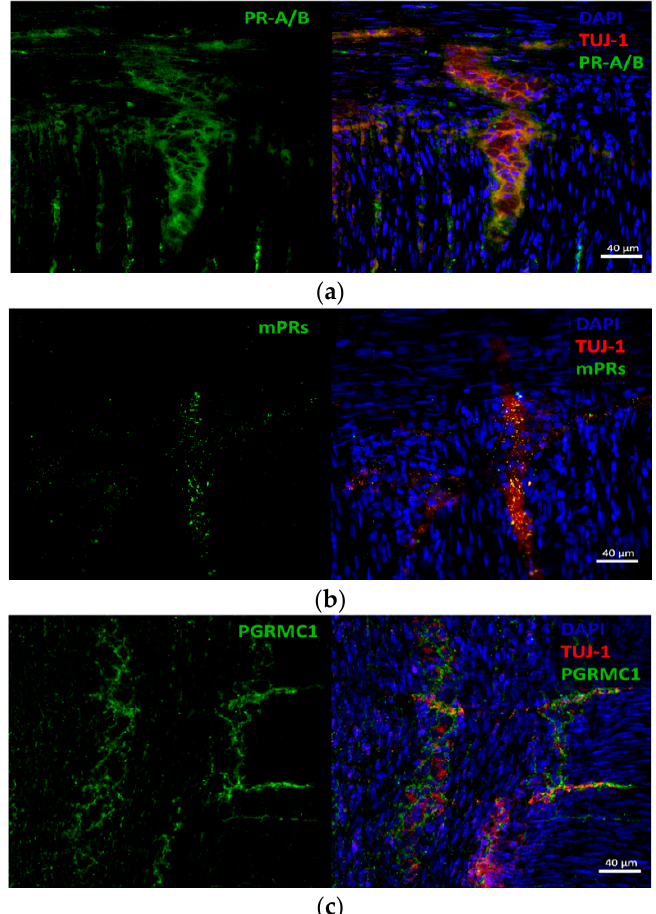
Figure 3. Confocal laser scanning microscopy myenteric ganglia in cryosections of Wistar rats at p30 for PR-A/B ( a ), mPR ( b ) and PGRMC1 ( c ). Cell nuclei were stained with DAPI in blue and the myen- teric plexuses in red with TUJ-1. ( a – c ) All receptors (stained in green) are colocalized with the ENS